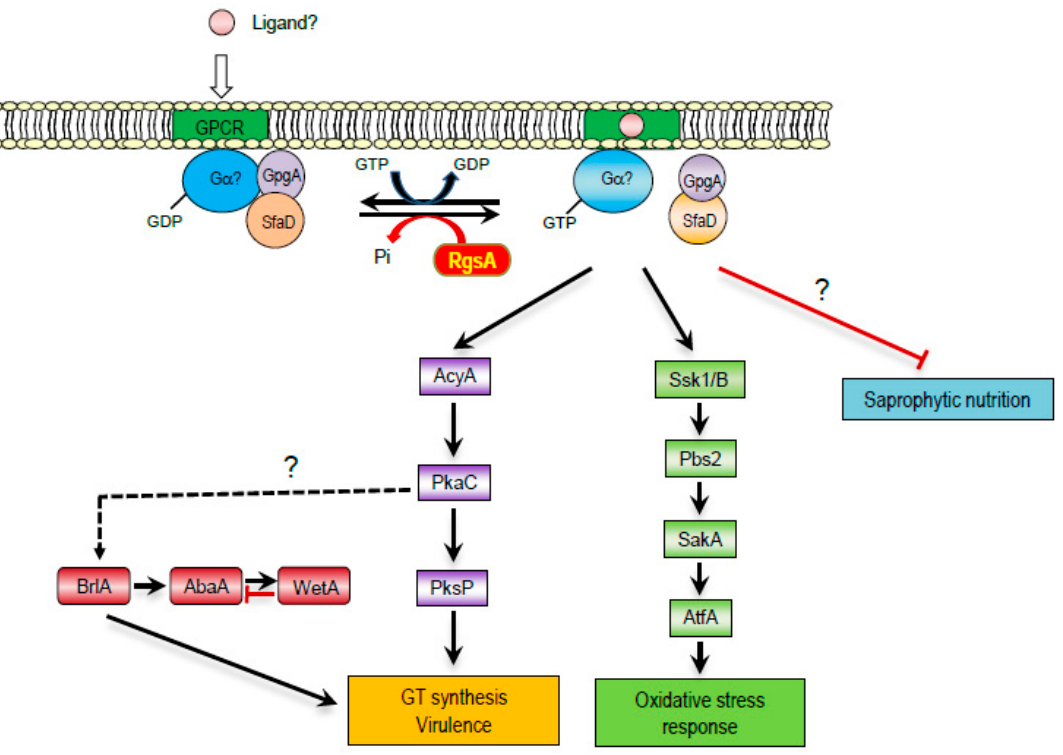
Figure 7. A model depicting the predicted roles of RgsA. RgsA negatively regulates the cAMP-PKA signaling pathway and stress-activated signaling pathway. This is predicted to be accomplished by RgsA’s role in attenuating the target heterotrimeric G proteins. The lack of RgsA leads to the accelerated and prolonged activation of the target G proteins; thus, enhanced activation of the cAMP-PKA signaling pathway and stress-activated signaling pathway, which in turn leads to increased production of GT, enhanced virulence, and an elevated oxidative stress response. In contrast, polysaccharide breakdown activity may be inhibited by the lack of rgsA .